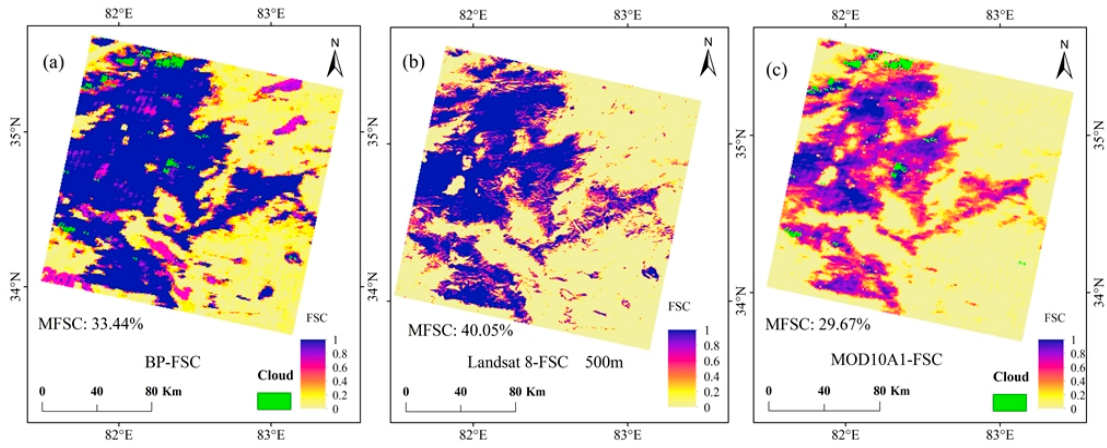
Figure 9. Comparison of the FSC spatial distributions from the BP-ANN model ( a ), Landsat 8 OLI ( b ) and MOD10A1 ( c ) in validation sub-region V1 on 14 October 2016.